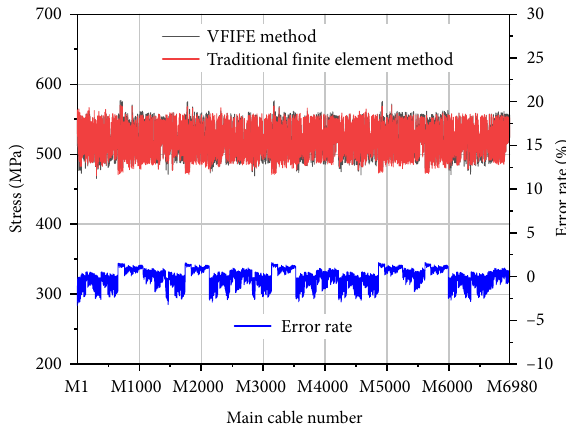
Figure 8. Comparison of the main cable stress